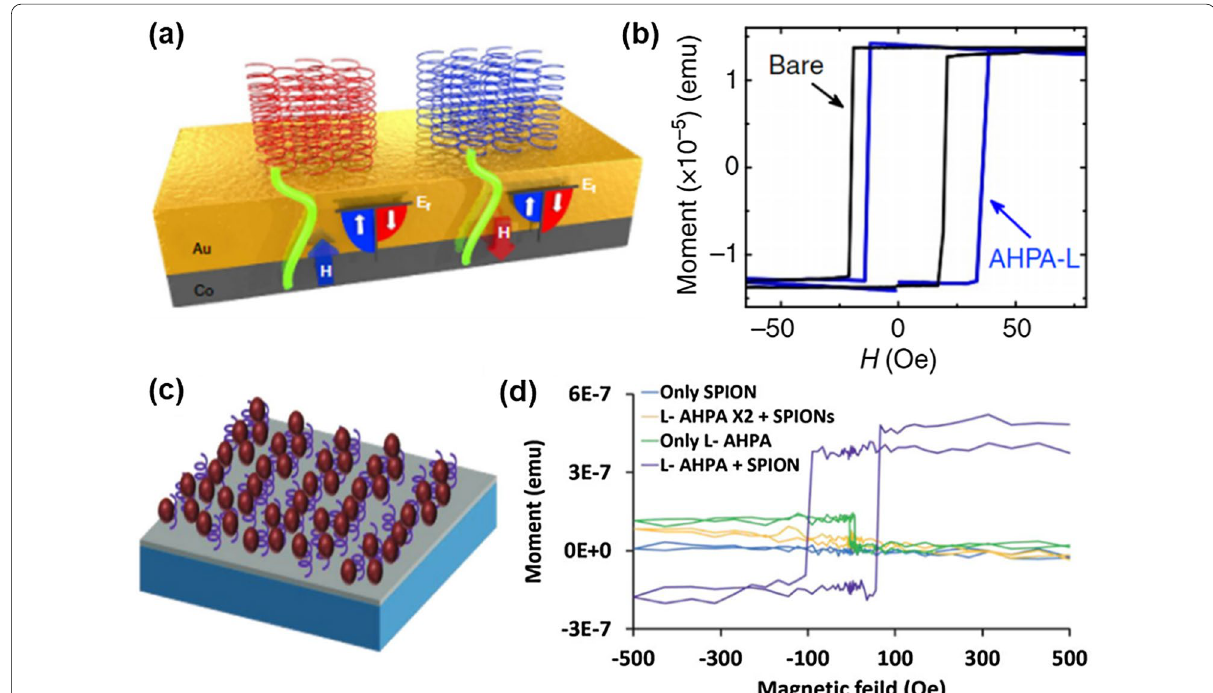
Fig. 8 a Schematic representation of samples with shifted hysteresis loop using metallic cobalt-gold bilayer with chiral polypeptide deposition. b Shifted magnetization hysteresis loop of l -polypeptide ( l -AHPA) deposited bilayer sample compared with bare bilayer sample. Reproduced with permission from [59]. Copyright 2017 Nature Publishing Group. c Schematic representation of single domain Fe 3 O 4 NPs (SPIONs) with ferromagnetism deposited on a chiral polypeptide layer. d SQUID measurements of magnetizations hysteresis loop. SPIONs with an l -AHPA layer exhibit hysteresis loop comparable to hysteresis loop of typical ferromagnetic NPs. Reproduced with permission from [60]. Copyright 2019